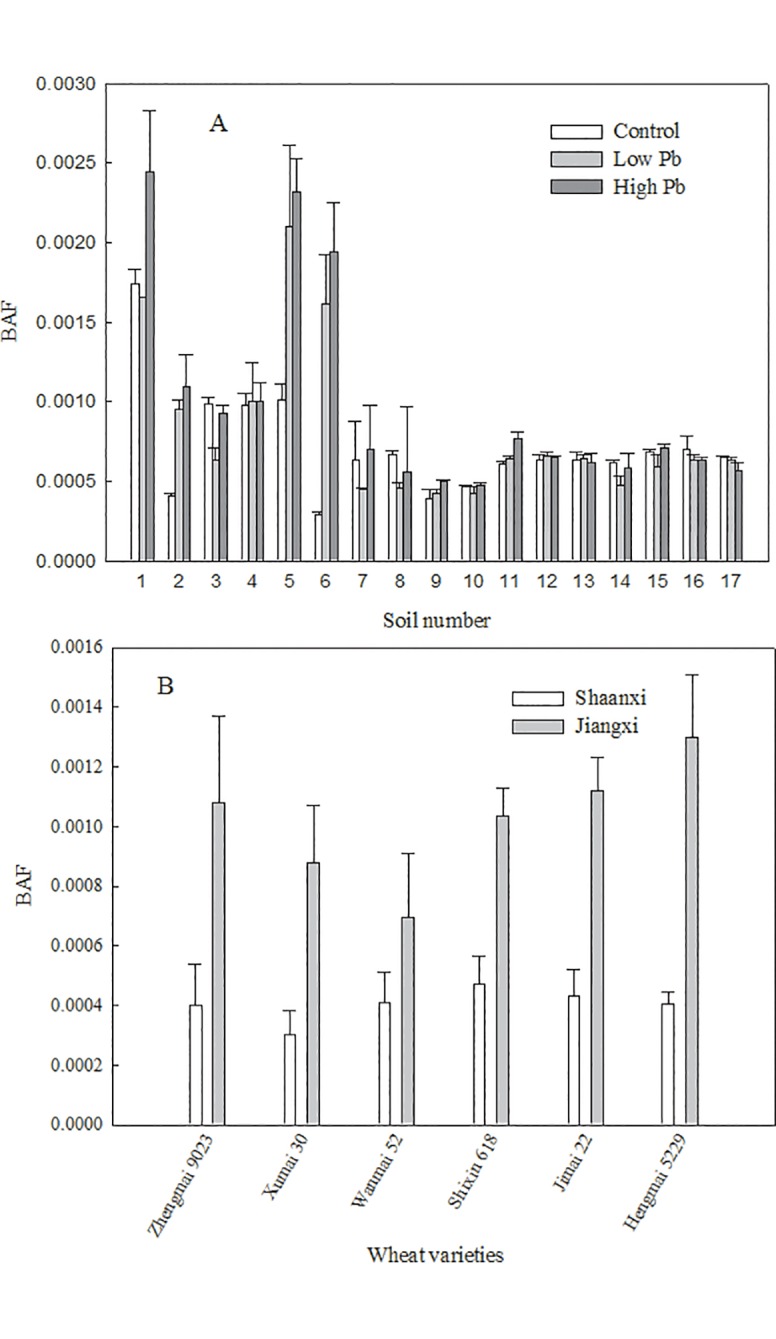
Effects of soil type (A) and wheat variety (B) on the bioaccumulation factor of Pb.